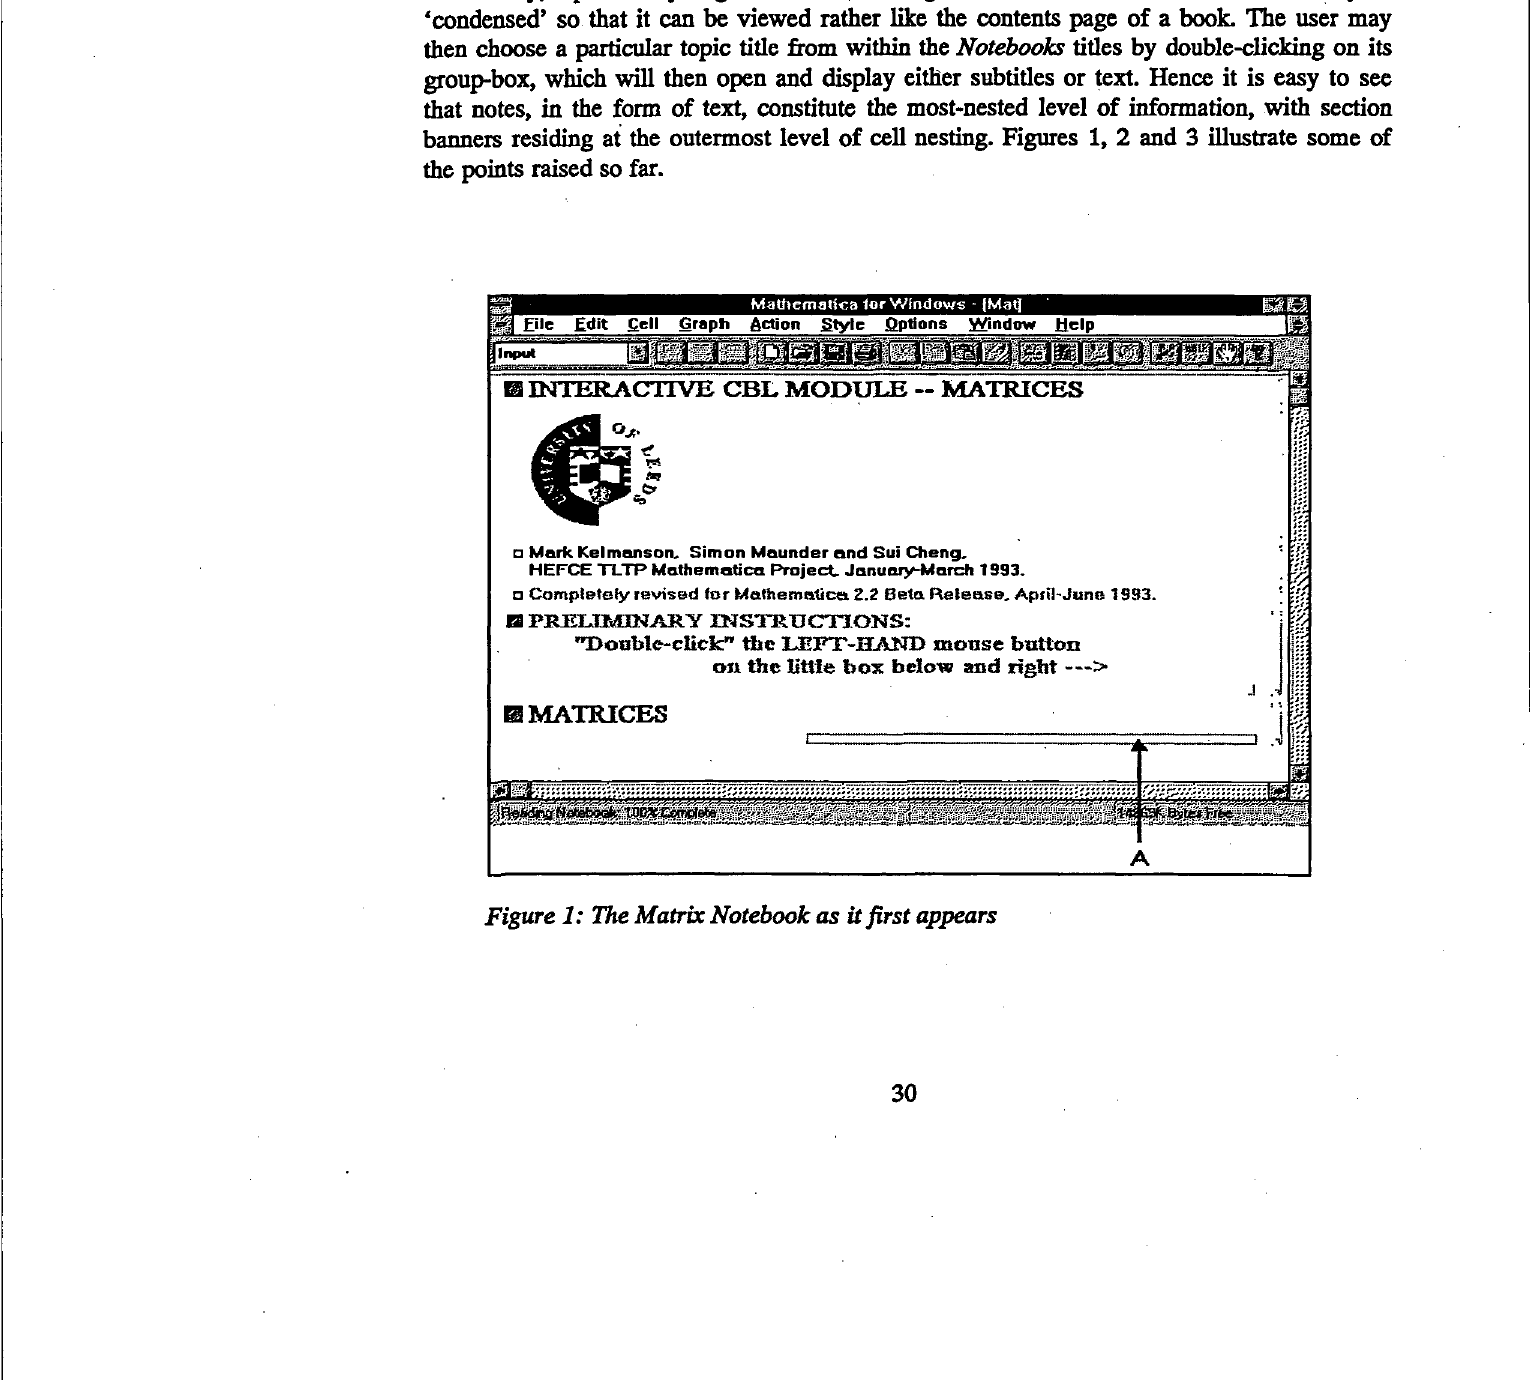
Figure 1: The Matrix Notebook as it first